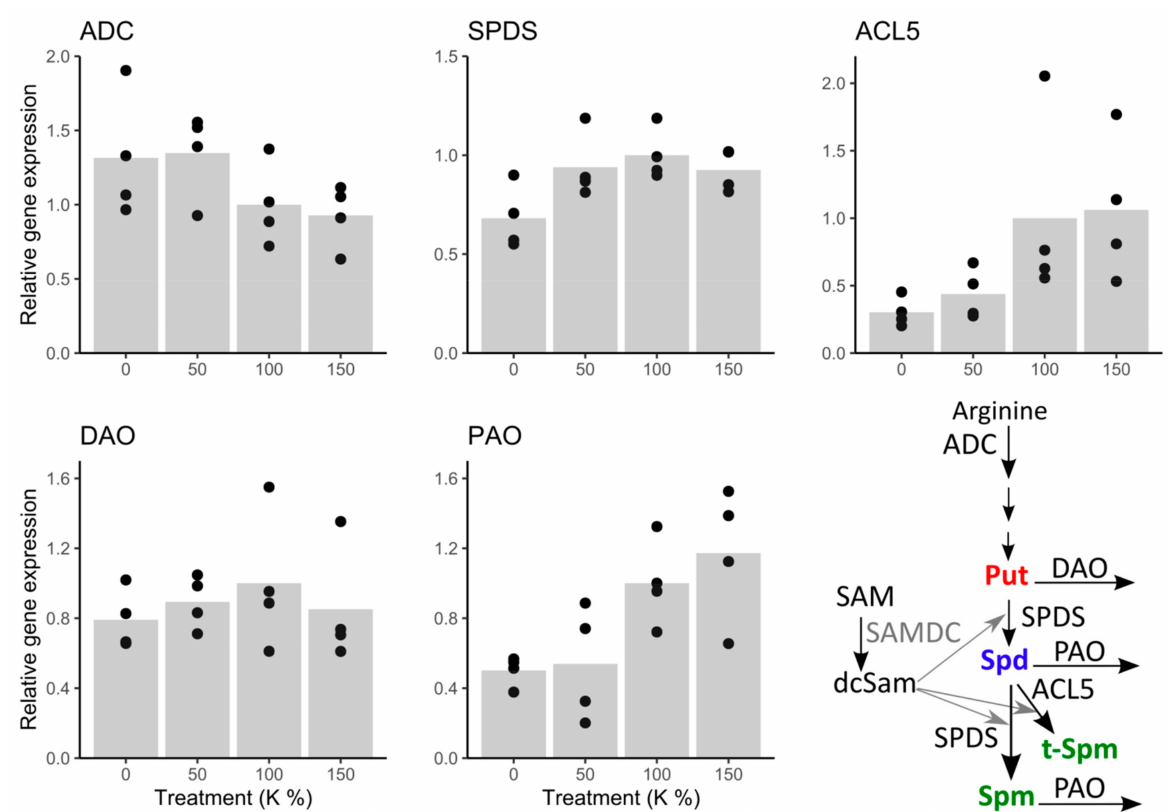
Figure 5. Expression of key enzyme genes in PA metabolic pathway under potassium (K) treatments. ADC expression showed an increasing trend, whereas the expression of SPDS, ACL5 , and PAO decreased, and the expression of DAO was not affected by potassium